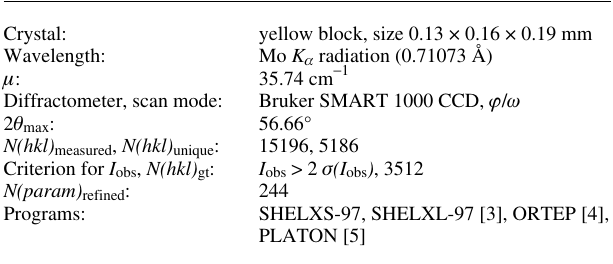
Table 1. Data collection and handling.